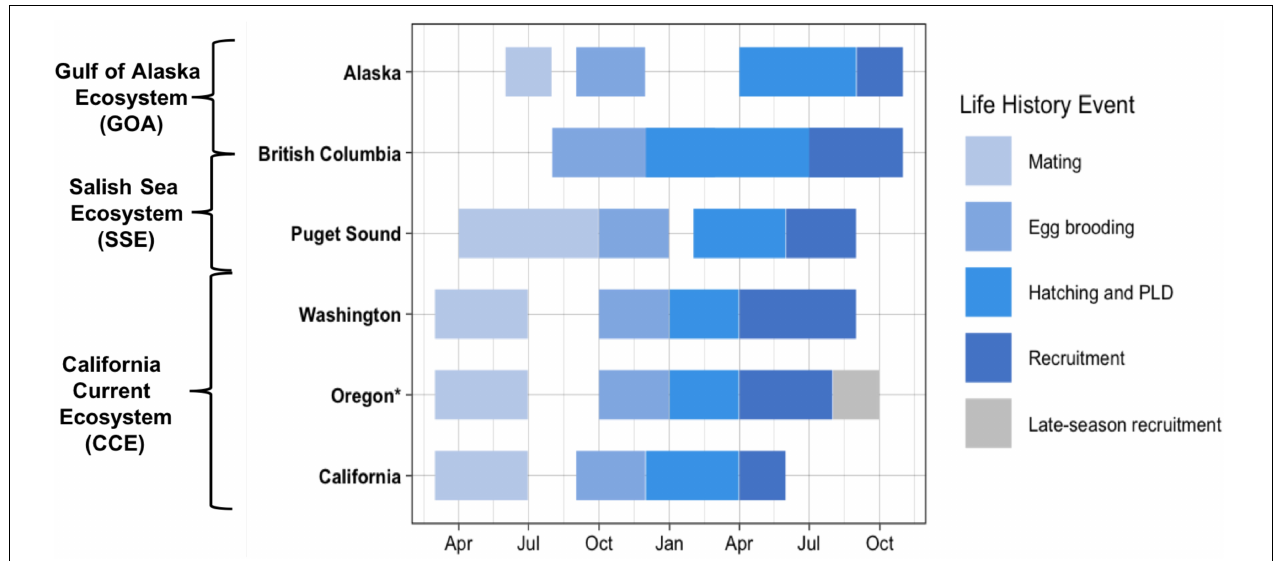
FIGURE 1 | Documented timing of Dungeness crab early life history from mating to recruitment of megalopae to the nearshore [data from Rasmuson (2013) review] (PLD: pelagic larval duration). Oregon late-season Dungeness crab recruits indicated in gray. California Current Ecosystem (CCE) locations include: coastal Washington, Oregon, and California. Puget Sound is within the Salish Sea Ecosystem (SSE) and Alaska is within the Gulf of Alaska (GOA) Ecosystem. British Columbia spans both the SSE and the GOA Ecosystem. Asterisk (*) indicates the region sampled for this